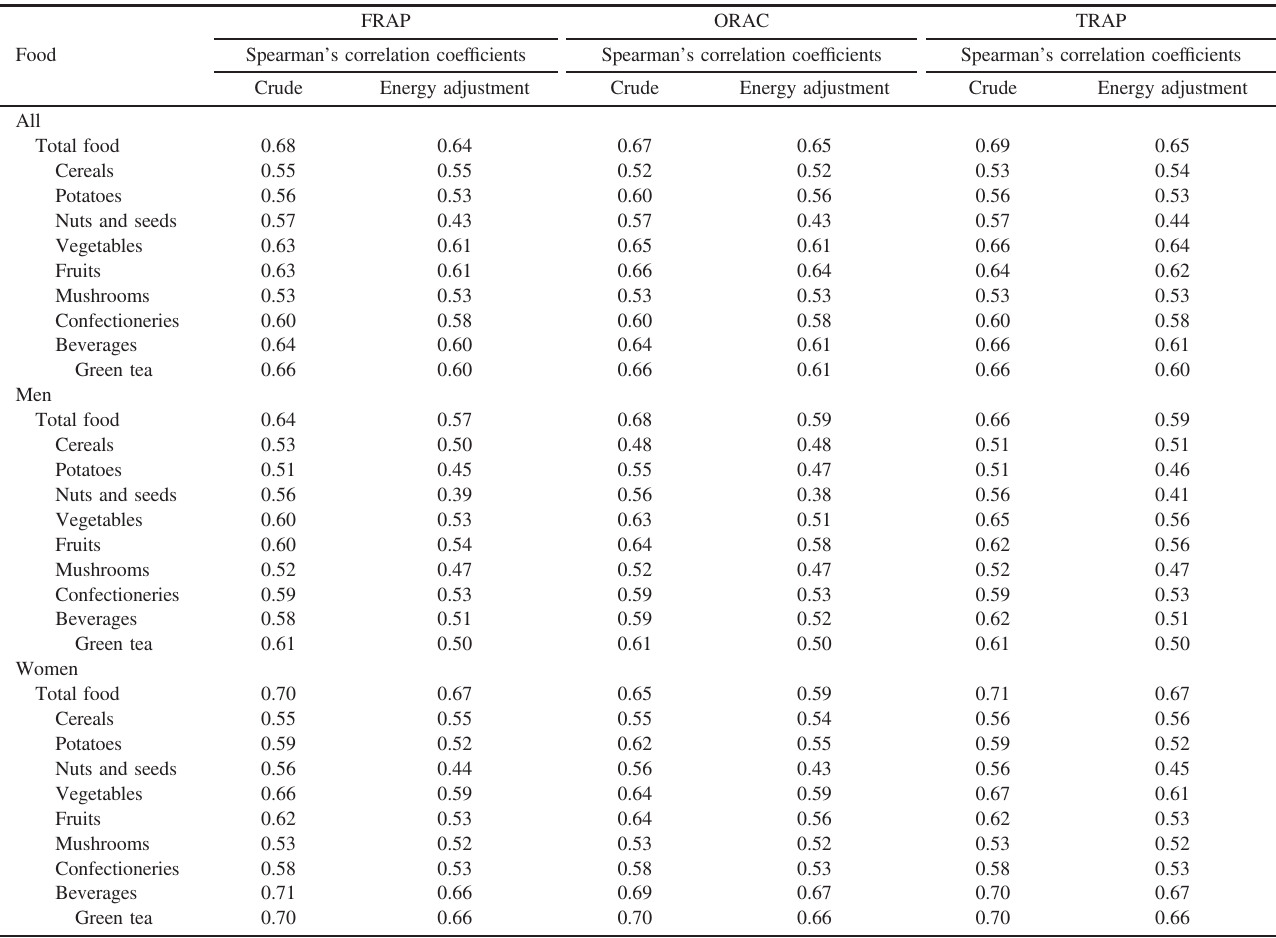
Table 4. Reproducibility of the FFQ-based NEAC of foods and beverages by FFQ_R a administered 1 year after and before FFQ_V b